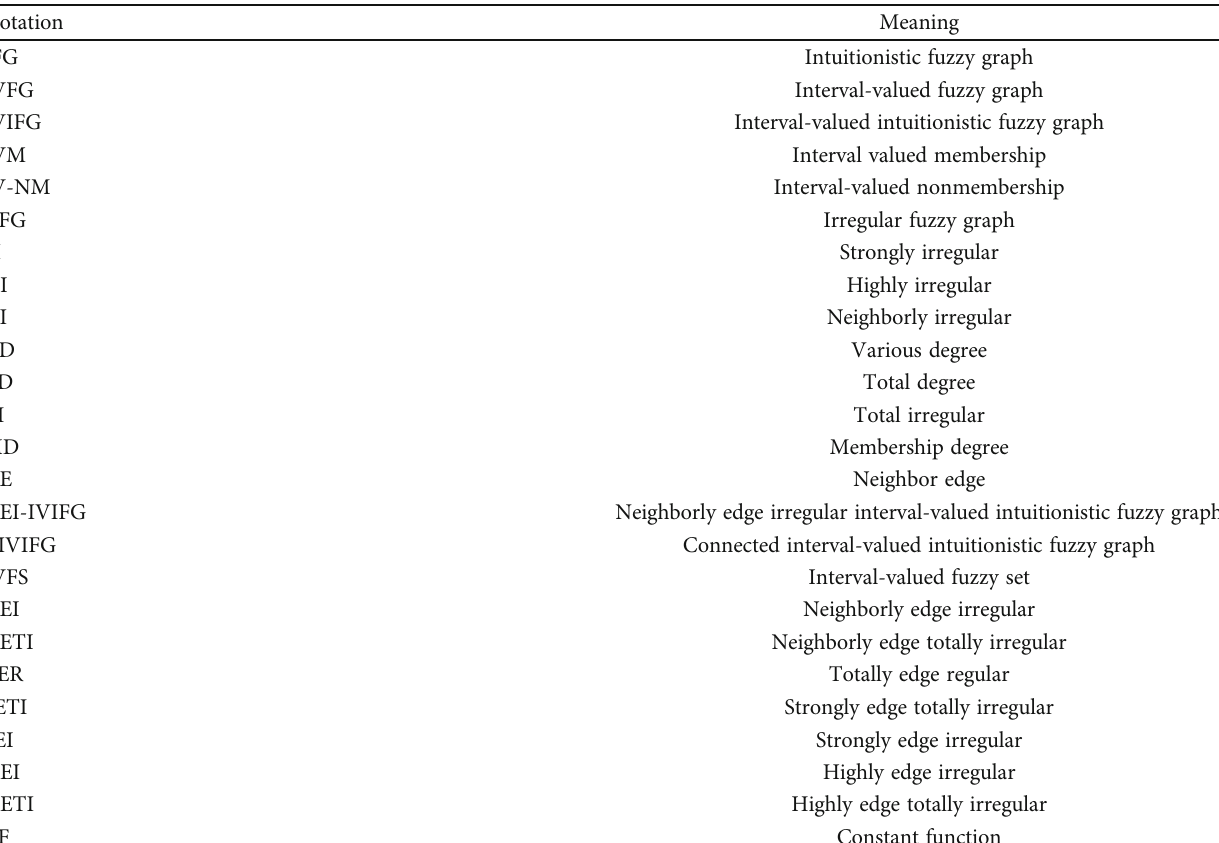
Table 1: Some basic